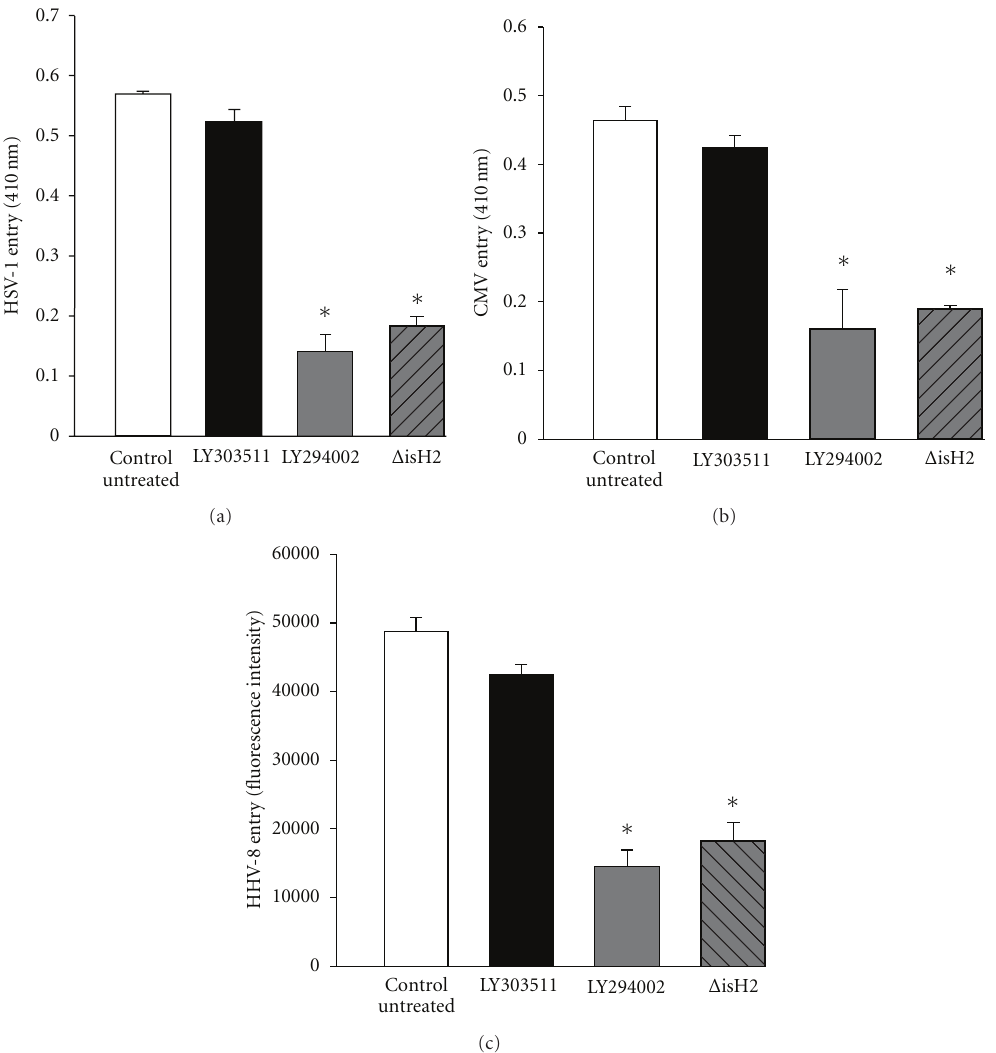
Figure 3: (a)–(c) Inhibition of PI3 Kinase signaling pathway negatively a ff ects herpesvirus entry into cell. Cells were either treated with the compound indicated or transfected with PI3-dominant negative plasmid ( Δ iSH2) followed by infection with HSV-1 (a), CMV (b), and HHV-8 (c). Results from viral entry assay are